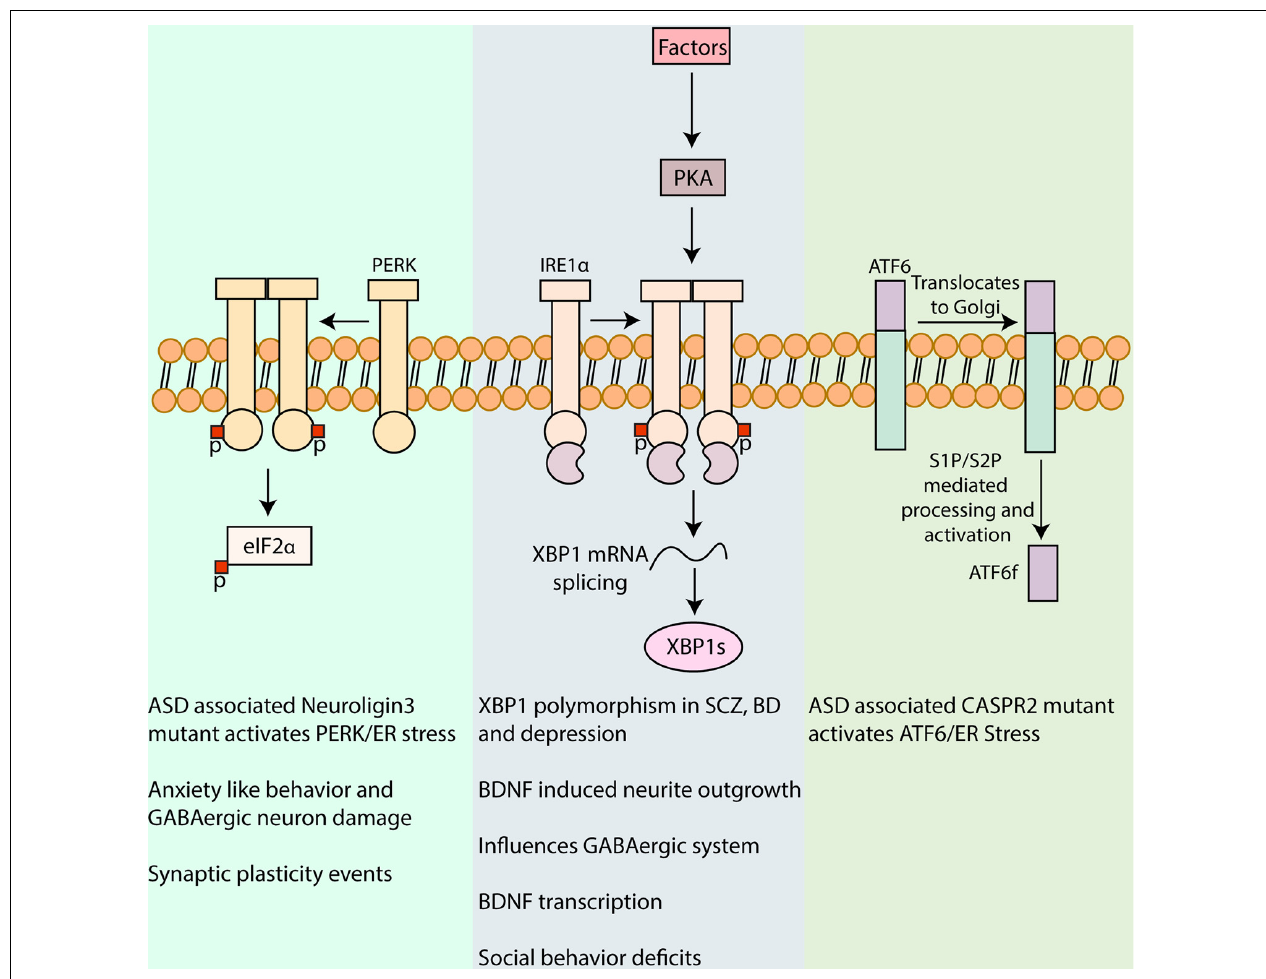
FIGURE 1 | Involvement of unfolded protein response (UPR) in neuropsychiatric disorders. UPR is a major pathway in protein quality control in cells including neurons and is characterized by signaling cascades in the ER, mediated by the protein sensors, PERK, IRE1 α , and activating transcription factor 6 (ATF6). Activation of PERK by autophosphorylation leads to phosphorylation of eukaryotic initiation factor 2 α (eIF2 α ), reducing the synthesis of critical synaptic proteins in neurons that affects memory processes and synaptic plasticity associated with intellectual disability, cognition, and addiction (Trinh et al., 2014; Placzek et al., 2016). PERK/eIF2 α has also been linked to the pathophysiology of autism spectrum disorder (ASD) and mutant Neuroligin3 induced UPR and to anxiety-like behavior and GABAergic neuron damage in the amygdala (Ulbrich et al., 2016; Trobiani et al., 2018). IRE1 α upon activation dimerizes and auto-phosphorylates which activates its kinase and RNase domain. The RNase domain further performs the unconventional splicing of XBP1 mRNA, resulting in spliced XBP1 mRNA that translates into a potent transcription factor, XBP1s (Uemura et al., 2009). XBP1 polymorphism in its promoter region has been associated with, Schizophrenia (SCZ), bipolar disorder (BD), and depression (Kakiuchi et al., 2003; Watanabe et al., 2006; Grunebaum et al., 2009). XBP1s also upregulates brain-derived neurotrophic factor (BDNF) that is a major factor involved in synaptic plasticity in health and disease. Activation of Protein kinase A (PKA) via cyclic AMP by different agents in the brain can in turn influence IRE1 α (Saito et al., 2018). Inhibition of IRE1 α ameliorated the social behavior deficits, a commonly observed trait in some neuropsychiatric disorders (Crider et al., 2018). Upon UPR induction, ATF6 is translocated to the Golgi apparatus for further processing by Site-1 and Site-2 proteases (S1P and S2P,